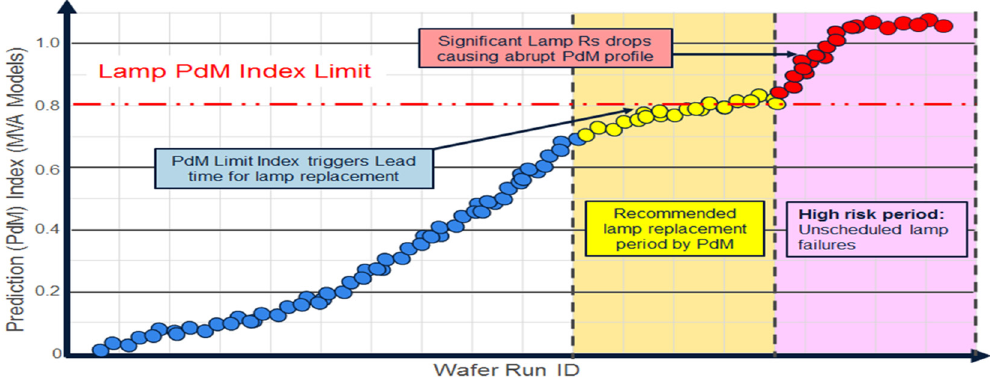
Figure 9. Illustration of epitaxial process lamp replacement predictive maintenance (PdM).